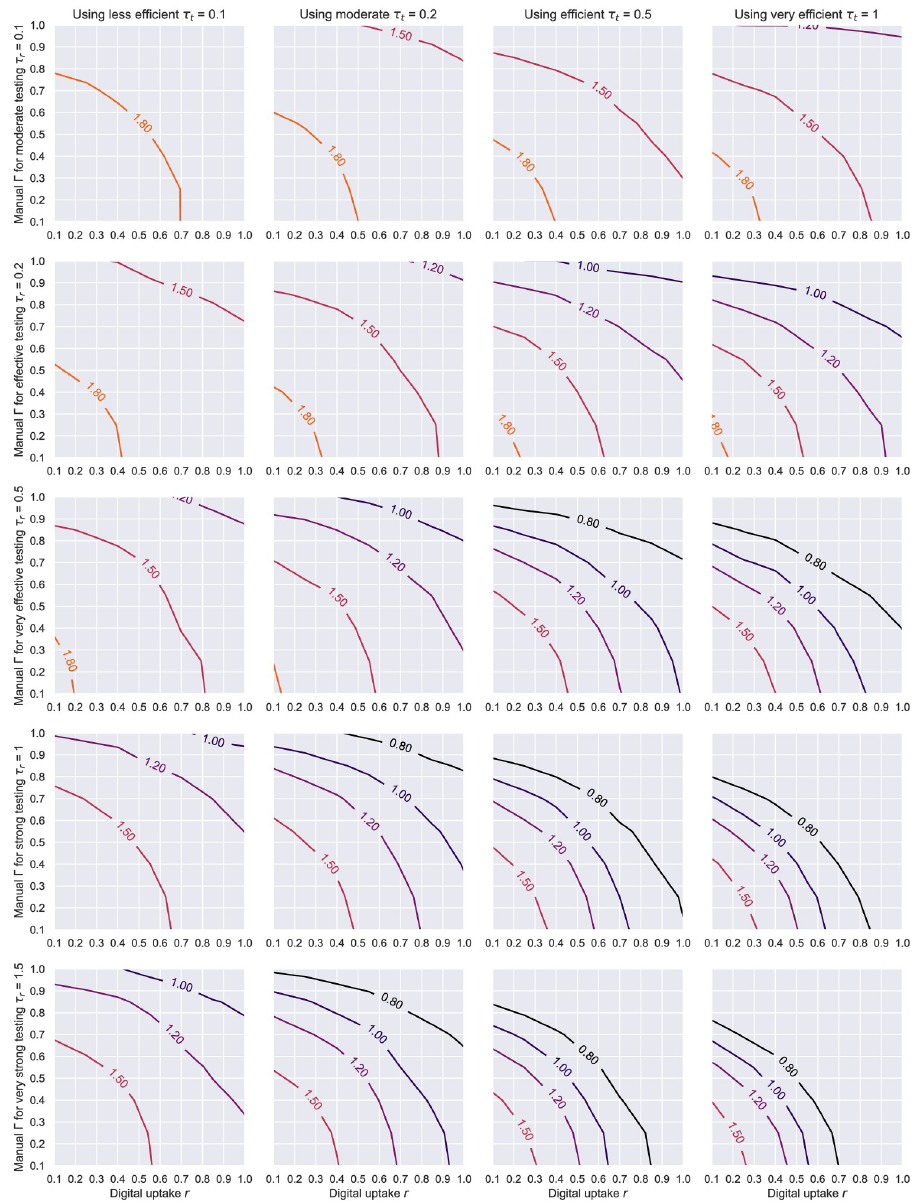
Fig 17. Social evolution—Contour plots of R based on the level of manual tracing overlap Γ and digital tracing uptake r . The results here correspond to the real Social Evolution network, dynamic over the studied period of 31 weeks, p = 0.2, η = .001. Each line represents a different testing level τ , while the columns showcase a less efficient (far a r left), a moderate (center-left), an efficient (center-right) and a very efficient (far right) average level of tracing engagement and isolation compliance given by τ t